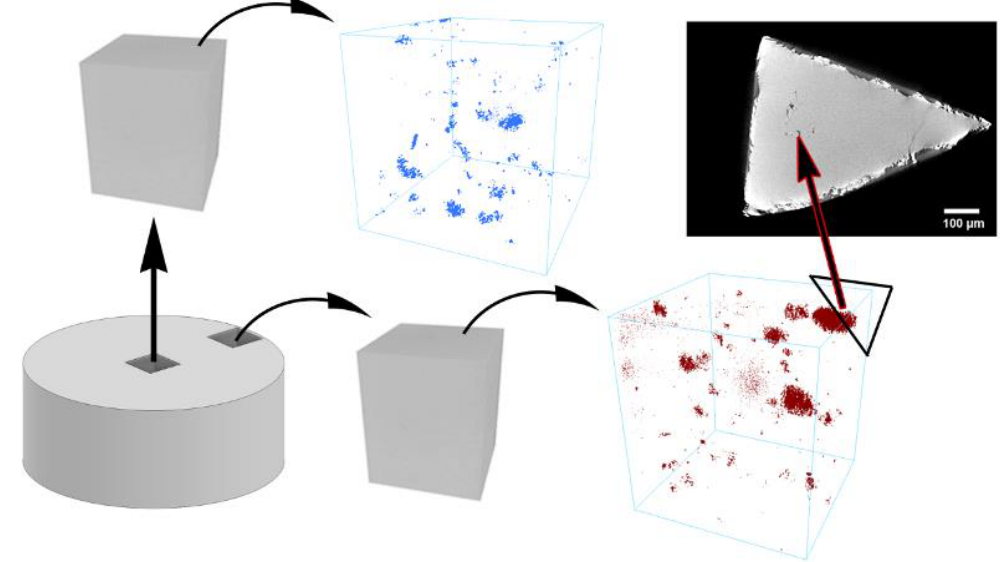
Figure 8. The porosity of the Zn–1Mg–0.5Sr from the center (blue pores) and the edge (red pores) of the billet with a 2D slice of cube corner acquired with a higher resolution to analyze the pore clusters.